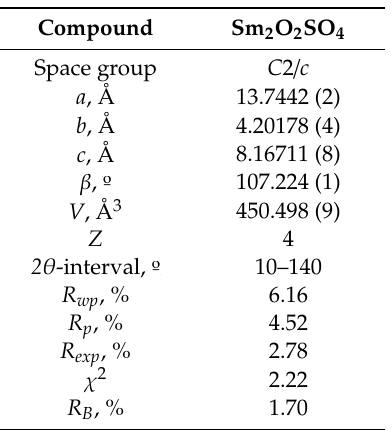
Table 1. Main parameters of processing and refinement of the Sm 2 O 2 SO 4 sample.